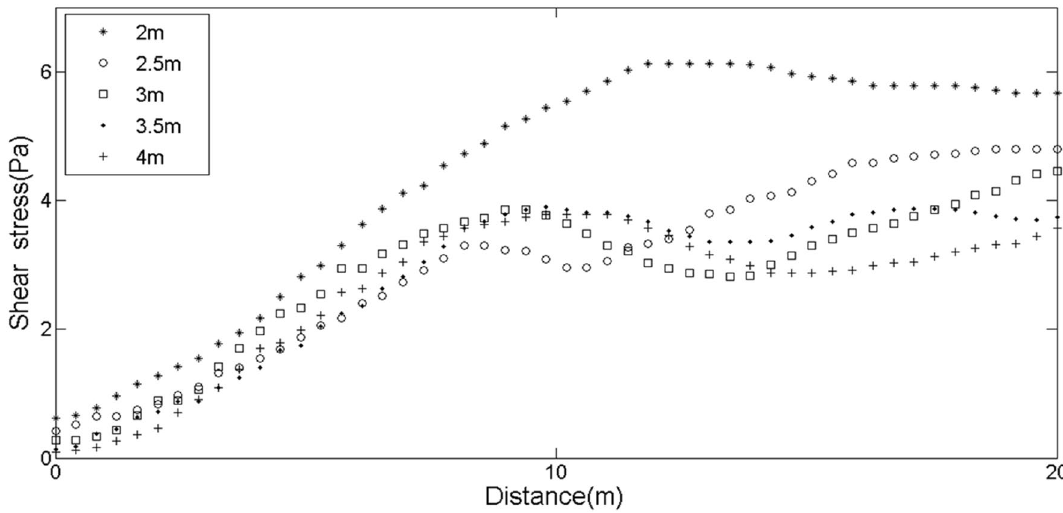
Figure 10. Changes of shear stress on the ground surface corresponding to different distances behind the leeward side at different heights of sand dune.